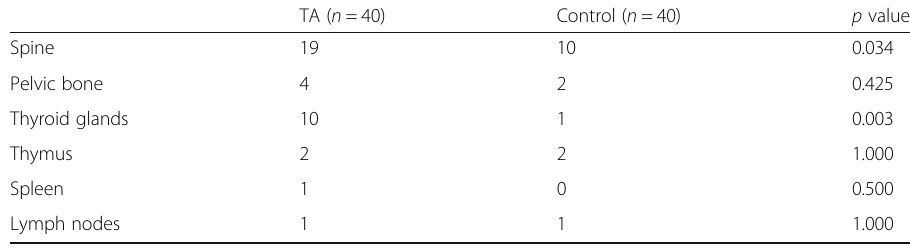
Table 4 Comparison of extra-vessel FDG uptake between patients with Takayasu arteritis and controls TA ( n = 40)